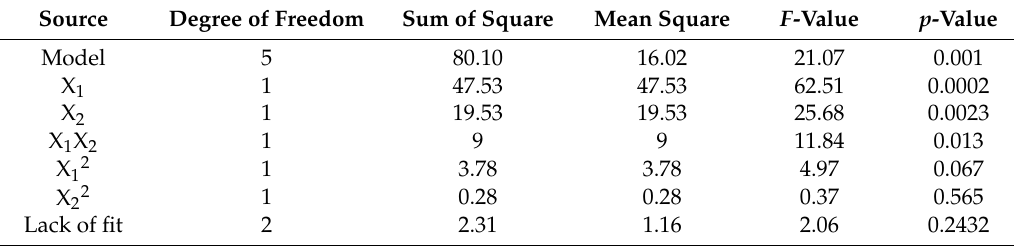
Table 3. The analysis of variance of the fitted quadratic model for potato starch yield